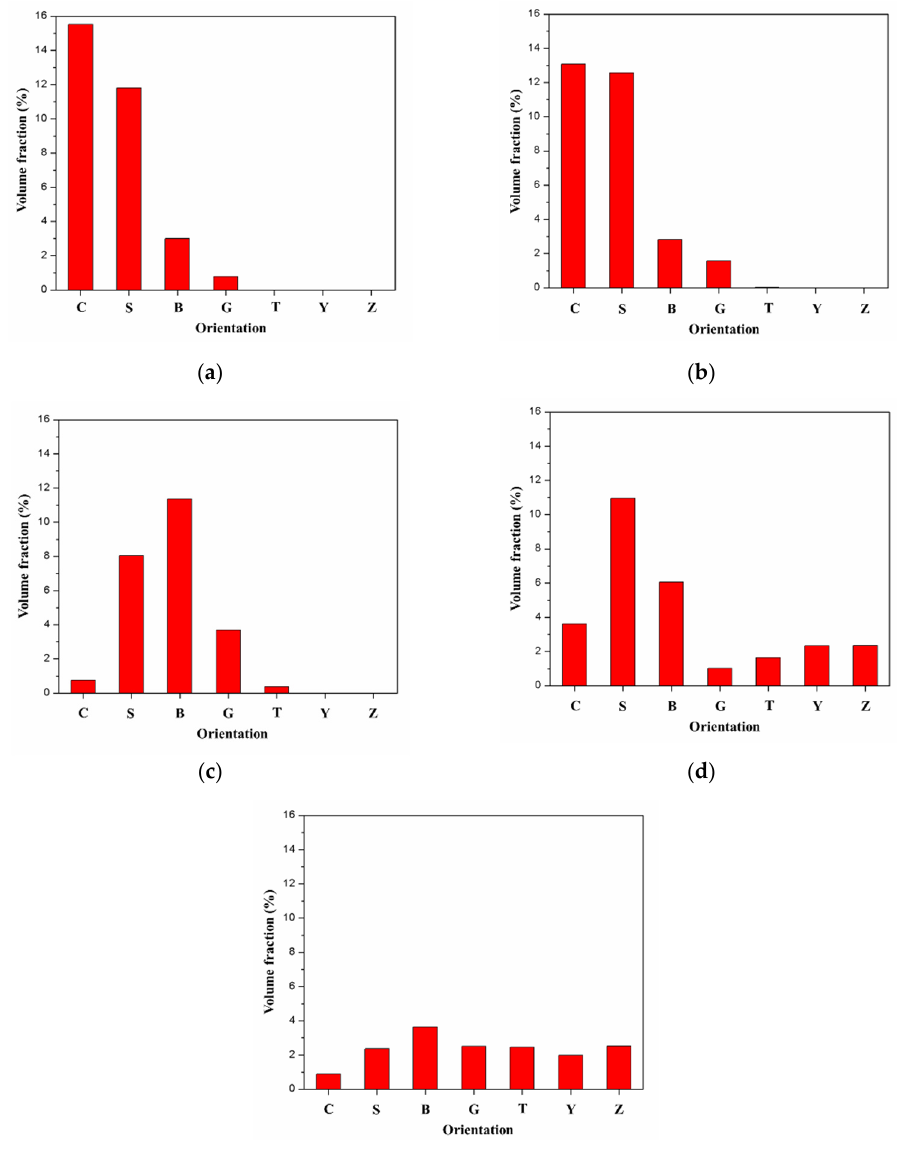
Figure 6. Volume fractions of specific orientations of rolling texture simulated using ( a ) FC-, ( b ) RC-, ( c ) MT-, and ( d ) MTCS-models and ( e ) from XRD measurements in Cu–30%Zn alloy after 90% reduction.